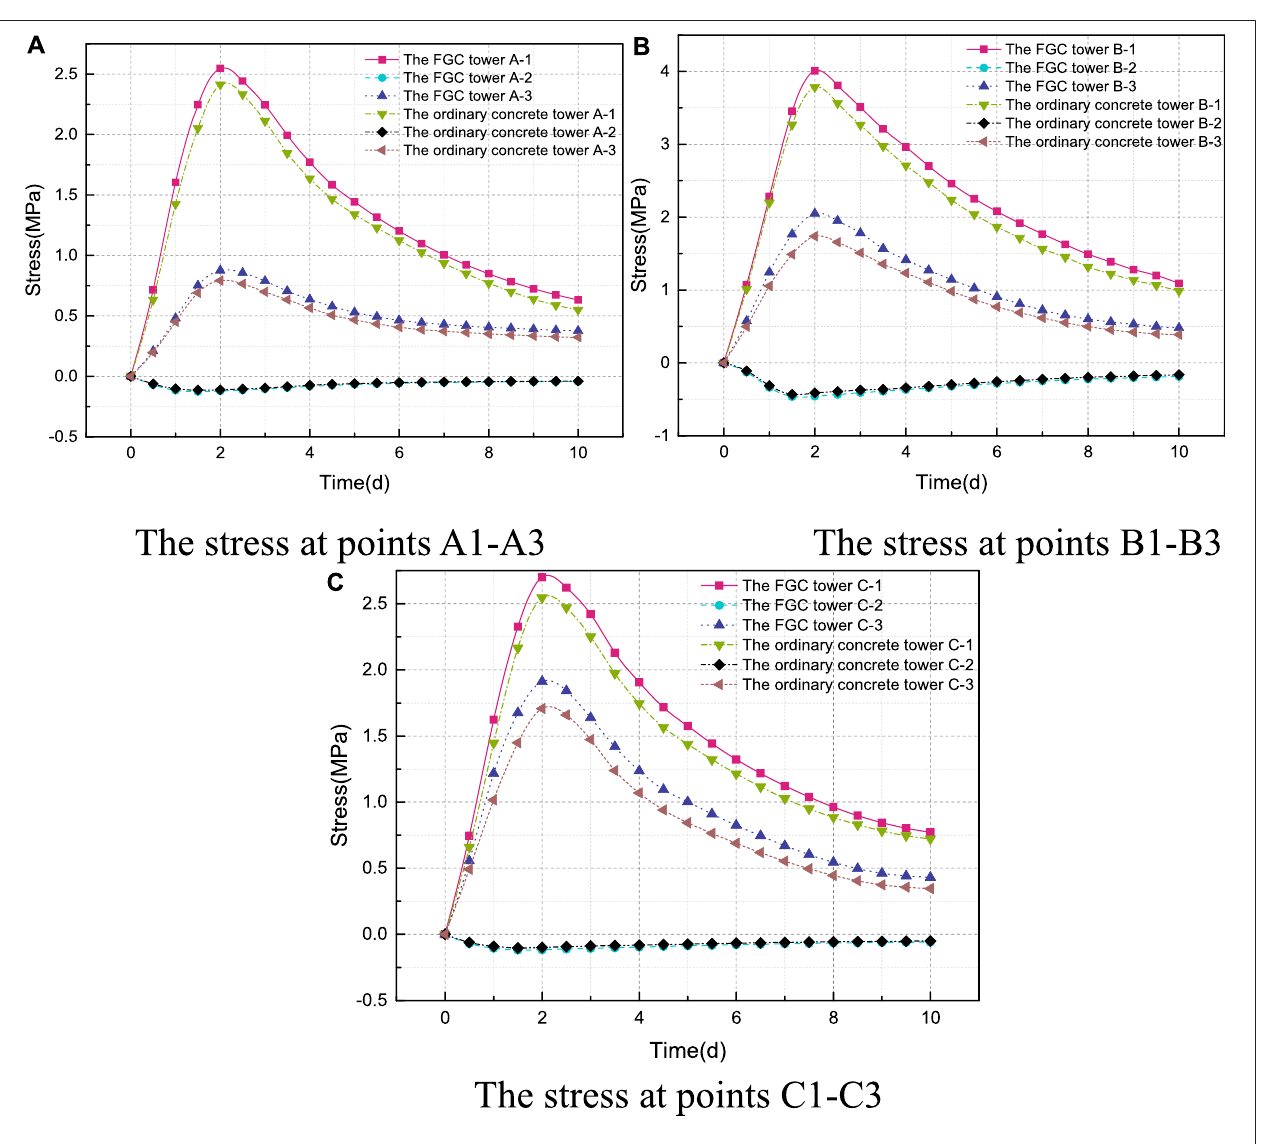
FIGURE 14 | The time-history curves of the maximum principal stress. (A) The stress at points A1 – A3. (B) The stress at points B1 – B3. (C) The stress at points C1 – C3.